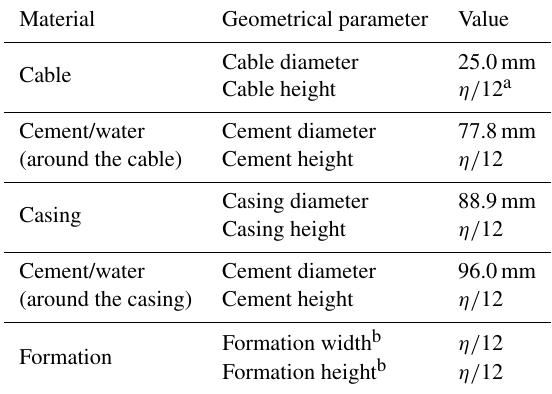
Table 2. Geometrical parameters used in numerical